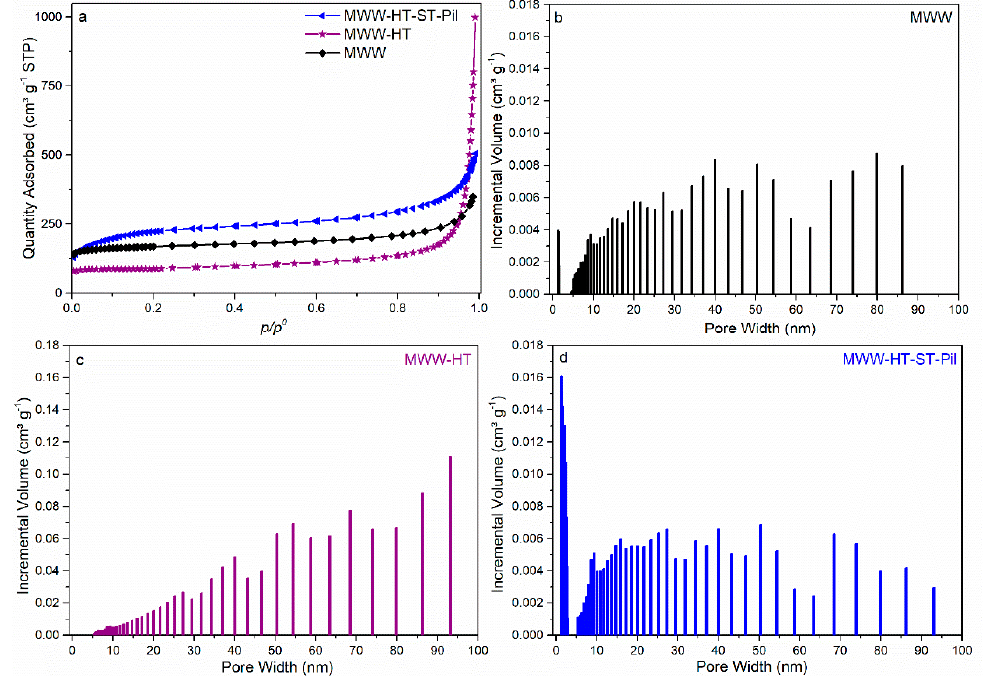
Figure 4. N 2 adsorption isotherms ( a ) and DFT pore size distribution of the standard-MWW ( b ), MWW-HT ( c ) and MWW-HT-ST-Pil ( d ) zeolitic products.